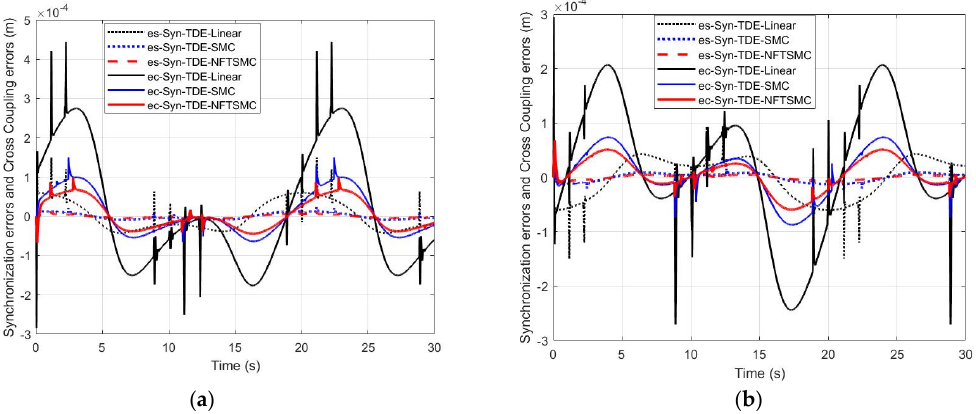
Figure 7. Time trajectories of synchronization errors and cross coupling errors of the control schemes, of joint 1 ( a ) and joint 2 ( b ). Table 4. The absolute average synchronization errors (AASE) and cross-coupling errors (AACE) of the control schemes, computed by MATLAB.